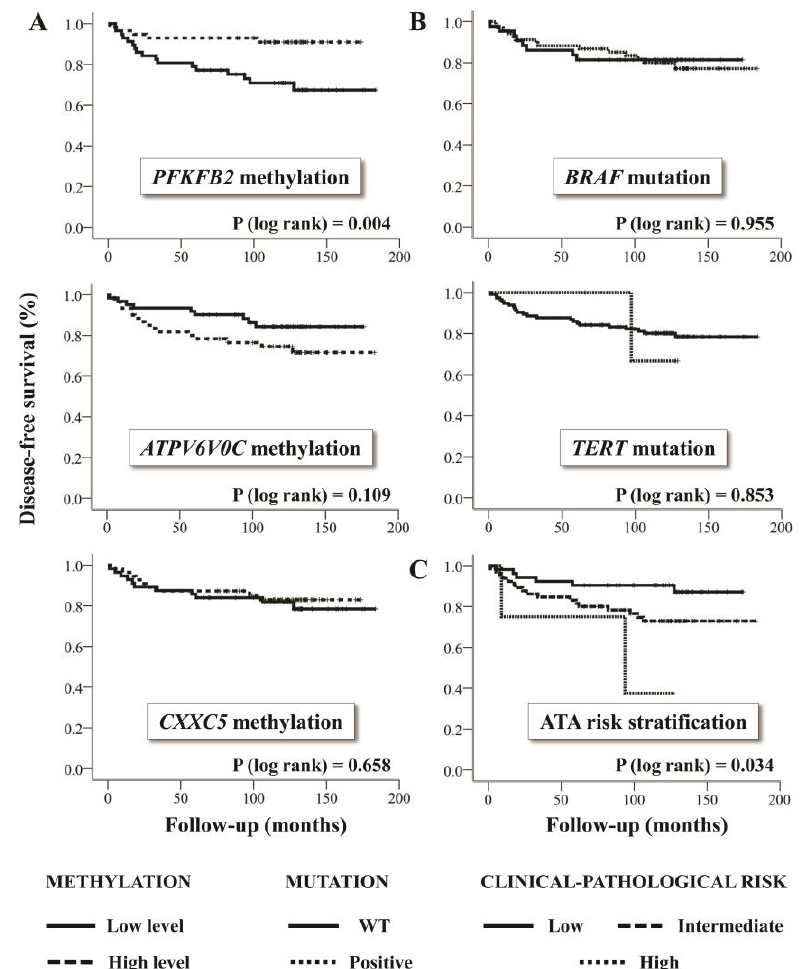
Figure 3. ( A ) Association of DNA methylation level (low and high) with disease-free survival.